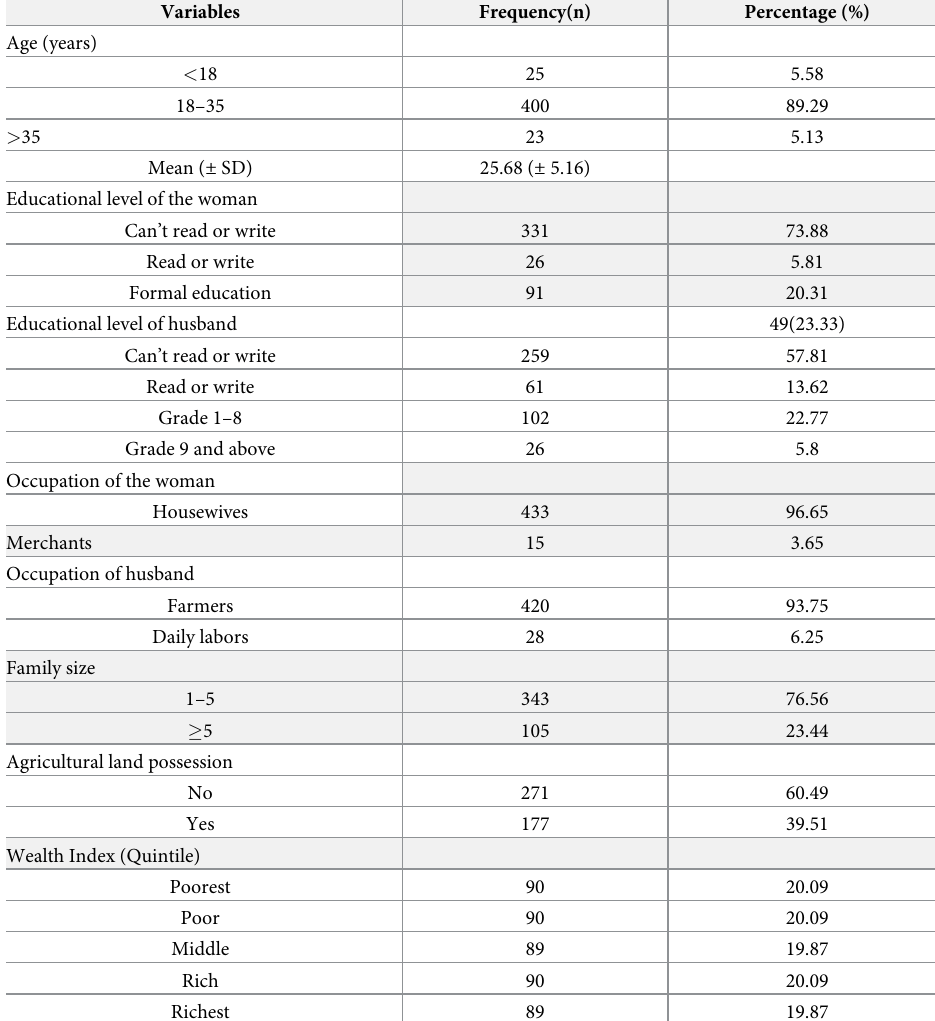
Table 1. Socio-demographic of pregnant women in Haramaya district, Eastern Ethiopia, 2021 (n =